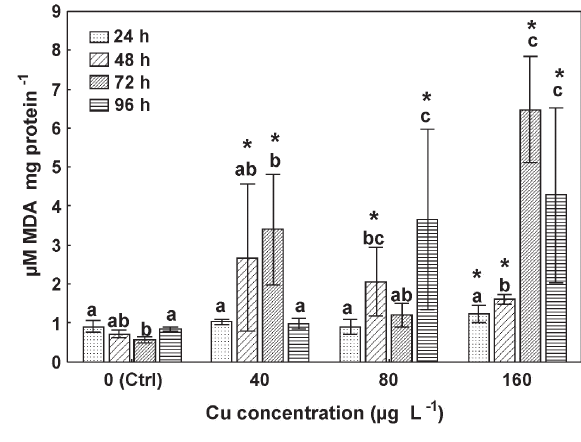
Fig . 3. – Lipid peroxidation of Zoea I of Lithodes santolla exposed to copper. Mean ± S.D. Columns of each treatment sharing different letters are significantly different. Asterisks denote significant dif- ferences from the corresponding control (Kruskal-Wallis, p <0.05). (S.D. = standard deviation).